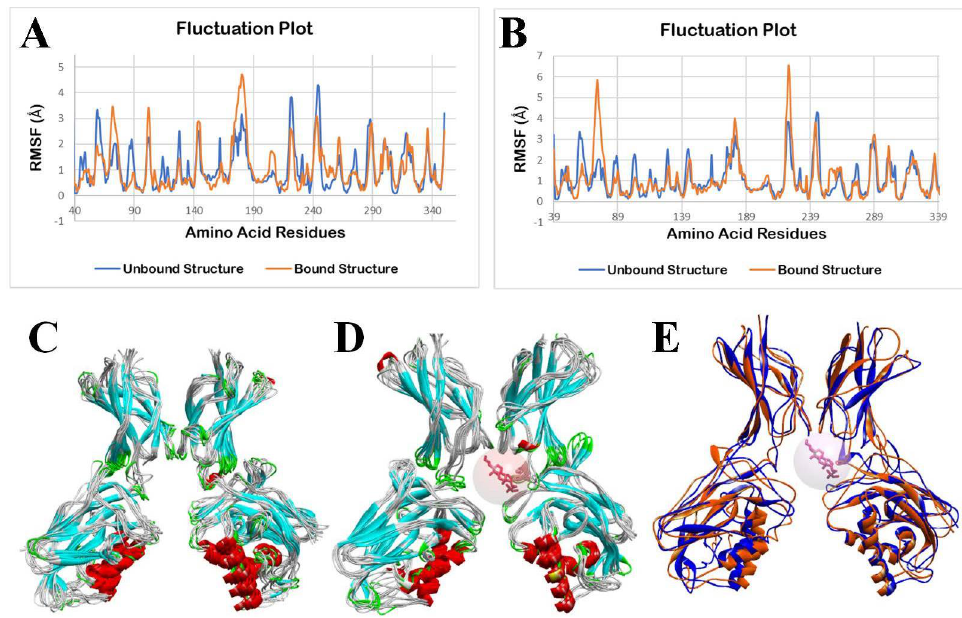
Figure 18. Molecular dynamics simulation of unbound and ergosterol peroxide bound NF − κ B p50 structures: ( A ) fluctuation plot of the number of amino acid residues of unbound (blue) and bound structure (orange) of NF − κ B p50 chain A, ( B ) fluctuation plot of the number of amino acid residues of unbound (blue) and bound structure (orange) of NF − κ B p50 chain B, ( C ) superimposition of unbound NF − κ B p50 structures from 0 ns to 10 ns, ( D ) superimposition of ergosterol peroxide bound NF − κ B p50 structures from 0 ns to 10 ns, and ( E ) superimposition of unbound NF − κ B p50 (blue) at 0 ns and ergosterol peroxide (pink) bound NF − κ B p50 (orange) at 10